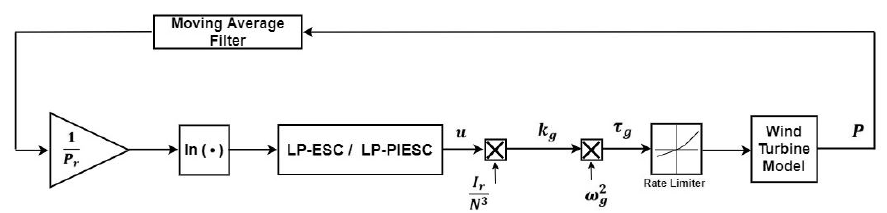
Figure 3. LP-ESC/LP-PIESC